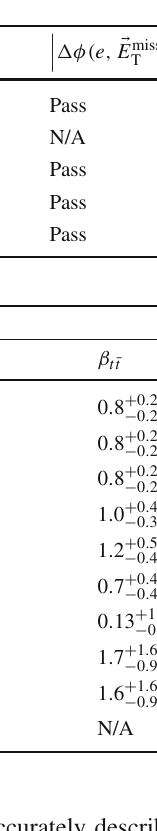
Table 7 Selection requirements applied in addition to the preselection (Table 2) in the CRs, VRs and SRs for the e ν J channel. “Pass”, ‘fail” or “N/A” mean that the requirement is passed, failed or not applied,